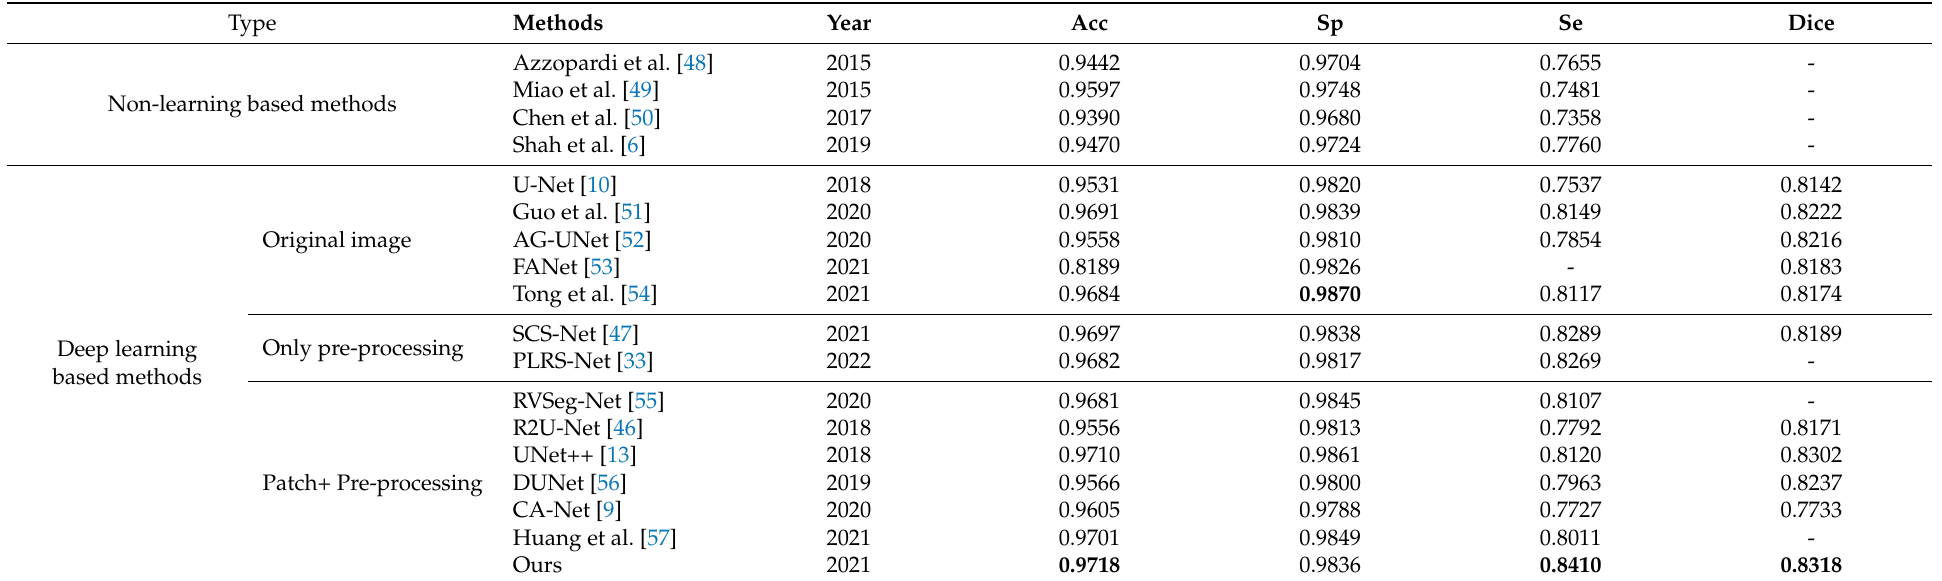
Table 5. Comparison with other methods on the DRIVE dataset.